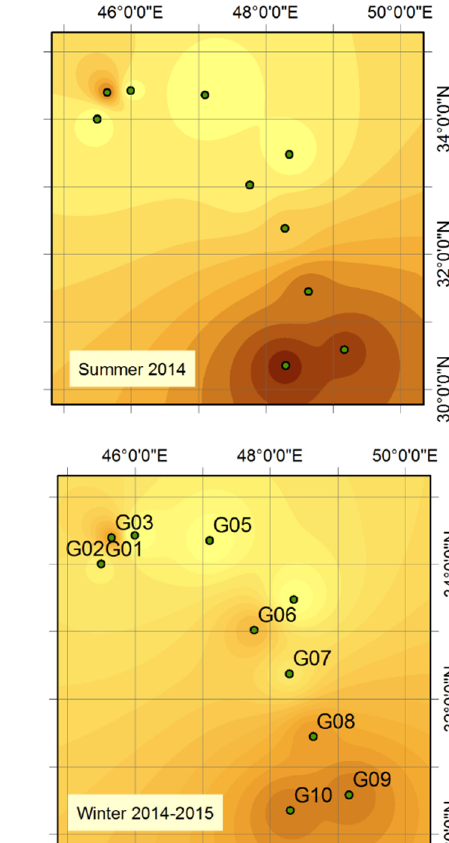
Table 5. Dust Deposition Rates vs. DEF. Chronic